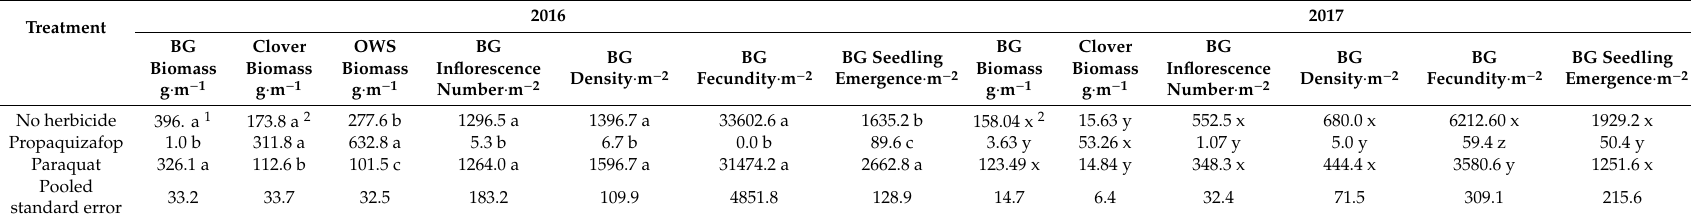
Table 6. Mean responses to herbicide alone on barley grass, clover and other weed species (OWS) biomass, barley grass density, inflorescence number, and seed production within a standing legume crop invaded by barley grass 12 and 24 months after application ( p <